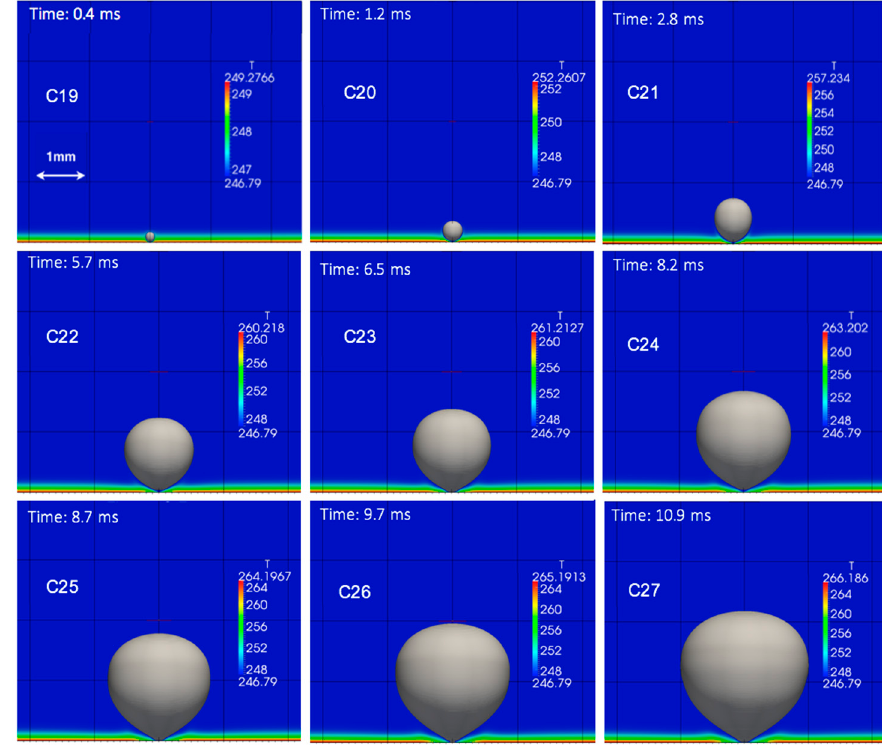
Figure 22. Spatial evolution of generated bubble at the time of detachment for each R134a case of the Series C parametric numerical simulations.